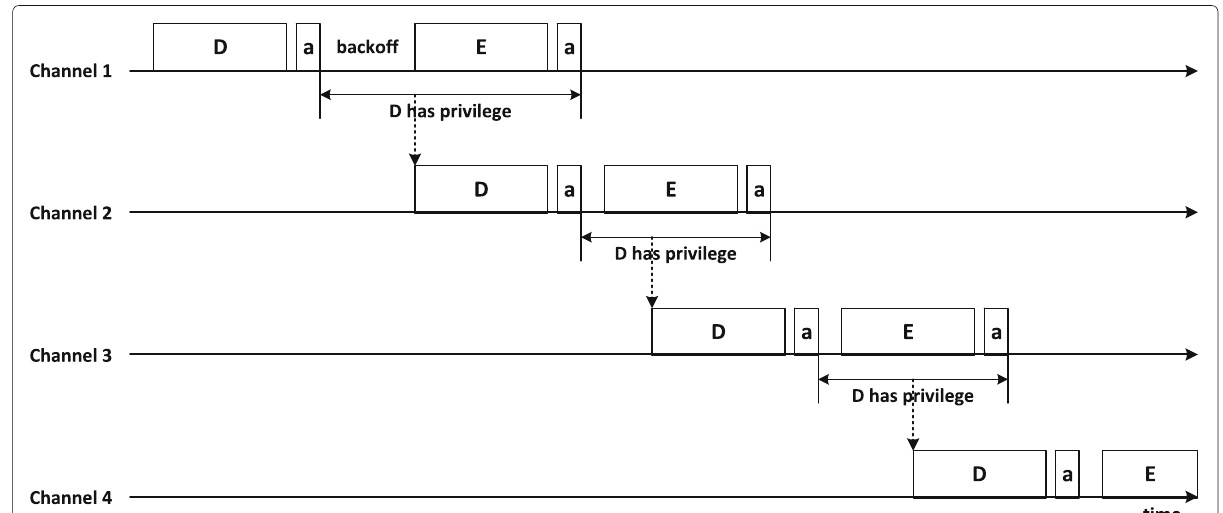
Fig. 7 Sequential privilege assignment. Node D randomly chooses channel 1 as its contention channel. After successfully sending its packet on channel 1, it gains privilege for channel 2. If the node successfully transmits a packet on channel 2, it will obtain privilege for the next channel, and so